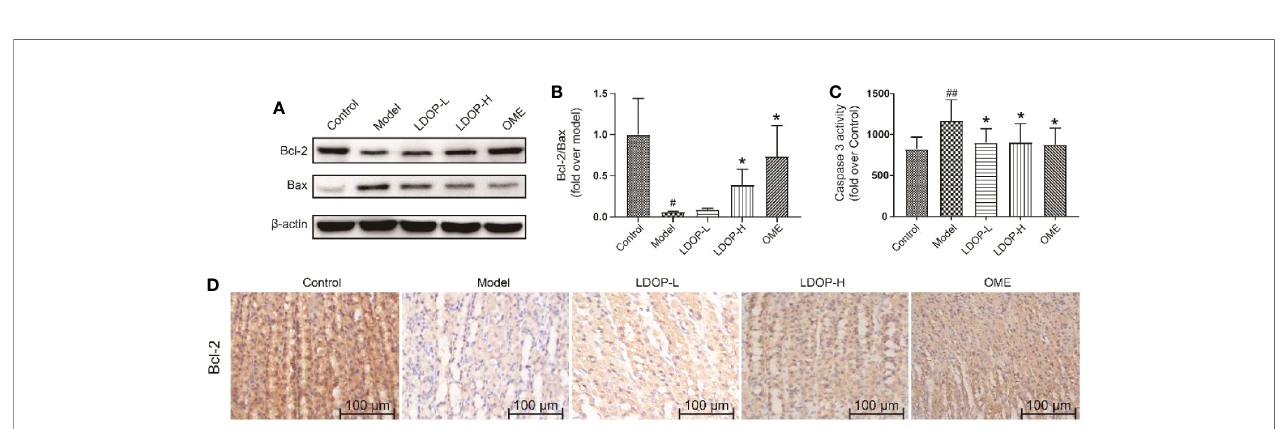
FIGURE 6 | Effects of LDOP-1 on the expression of Bax, Bcl-2 and caspase 3 in vivo. The expression of Bax and Bcl 2 were detected by Western blot (A) . Statistical analysis on Bcl-2/Bax (B) . The production of caspase 3 was measured by biochemical markers kit (C) . Immunohistochemical image of Bcl-2 (D) measured by immunohistochemical analysis (400×, brown yellow granules indicate positive reaction). Data are expressed as the mean ±SD of three independent experiments. # P<0.05, ## P<0.01 compare the control group; *P<0.05 compare model group. LDOP-L stood for LDOP-1-L, LDOP-H stood for